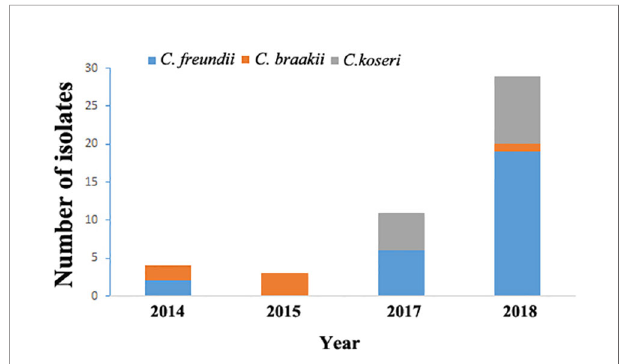
FIGURE 1 | Distribution of Citrobacter isolates by year in Maanshan people ’ s hospital, Anhui Province, China from 2014 to